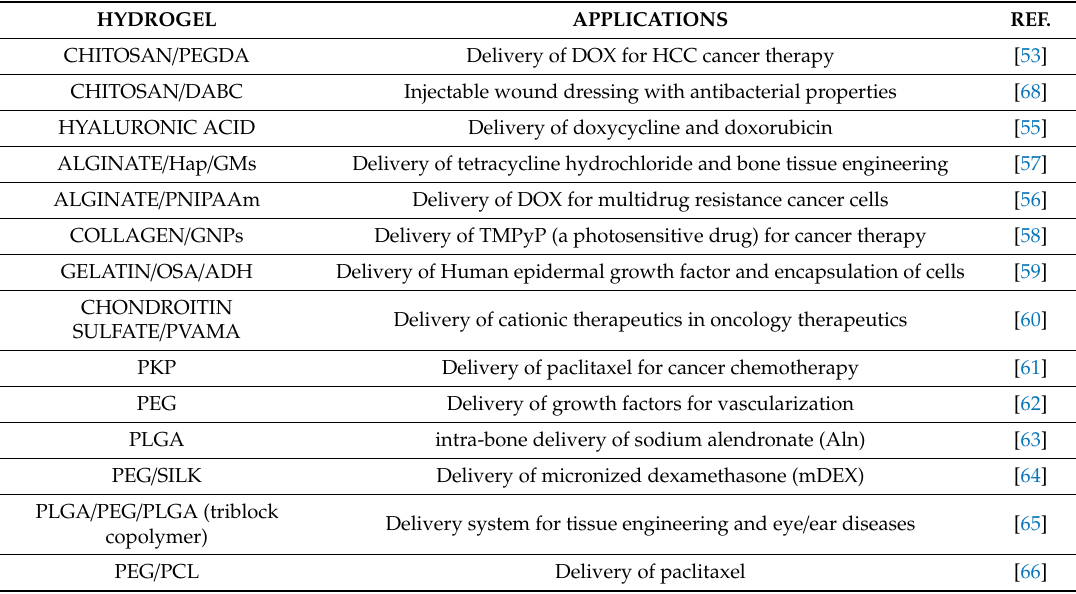
Table 1. Injectable hydrogel systems and their